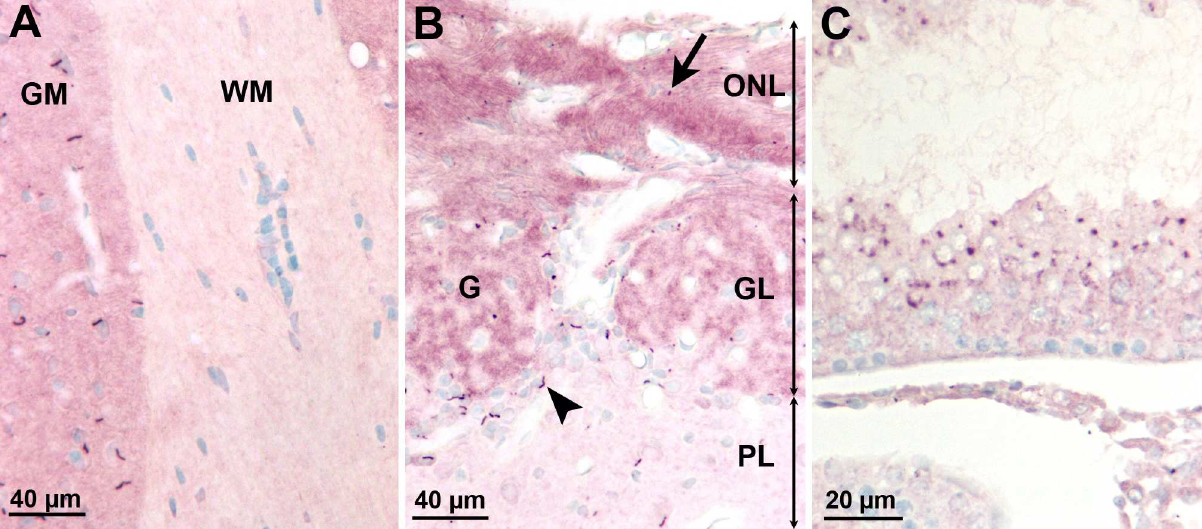
Fig 1. AC3 expression in adult mouse cilia. (A) Brain: note the long AC3 positive cilia in grey matter and the absenceof AC3 positive cilia in white matter (corpus callosum).(B) Peripherallayers of the olfactory bulb: note the short AC3-positive cilia in the olfactory nerve layer (arrow) as comparedto the long cilia of cells aroundthe olfactory glomeruli(arrow head). (C) Seminiferous tubule: AC3 is present in the developing acrosomeof round spermatids. Abbreviations: GM, grey matter; WM, white matter; ONL, olfactory nerve layer; G, glomerulus; GL, glomerular layer; PL, plexiform layer.